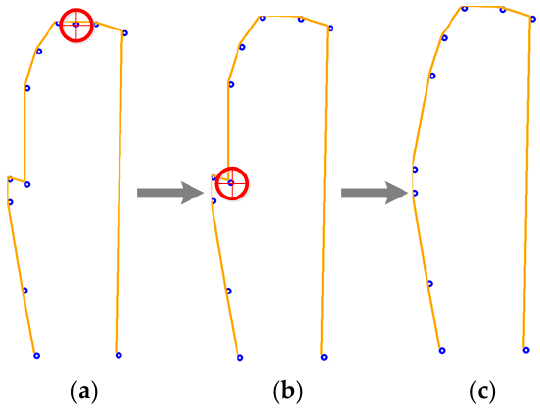
Figure 11. Characteristic array down adjusting, ( a ) characteristic array of size 12; ( b ) characteristic array of size 11 ( c ) final characteristic array of size 10.